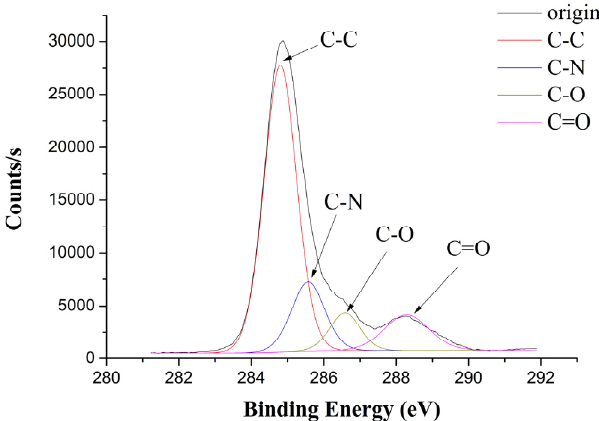
Figure 15. The full element spectrum of the welding zone of TGMPP.